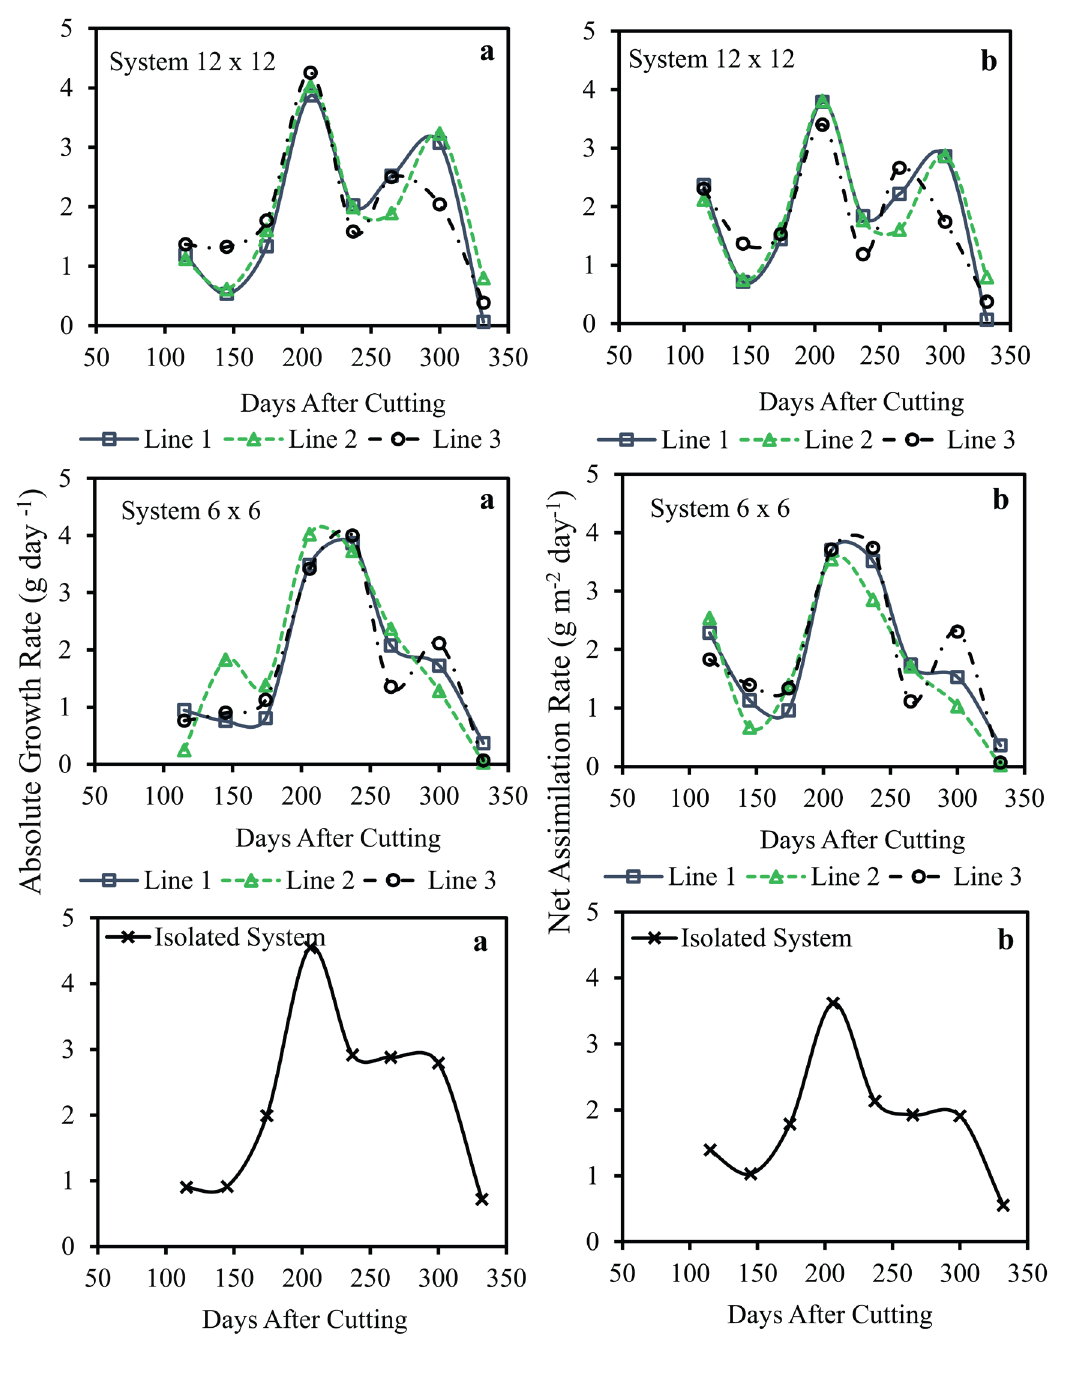
Figure 5 - Absolute growth rate ( a ) and net assimilation rate ( b ) of sugarcane in agroforestry and isolated systems in different lines of evaluation throughout the days after